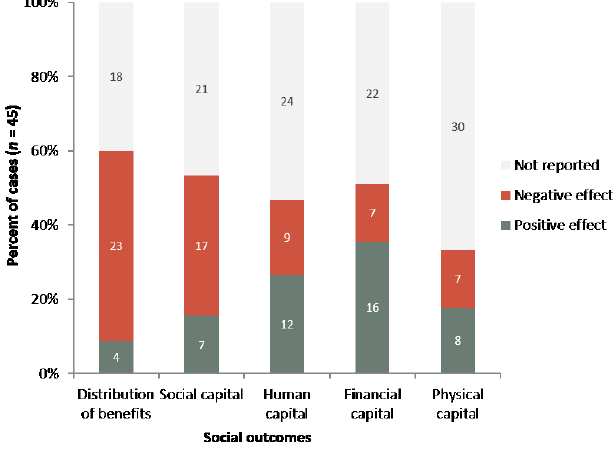
Fig. 6 . Percent of cases that reported positive and negative social outcomes. Total number of cases assessed was 45 (11 cases that reported mixed positive and negative outcomes were removed from this analysis). Counts in the bar graph represent the number of